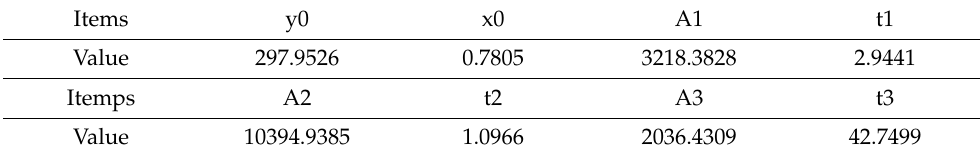
Table 2. Coefficient of regression equation for decay heat of PWR used fuels